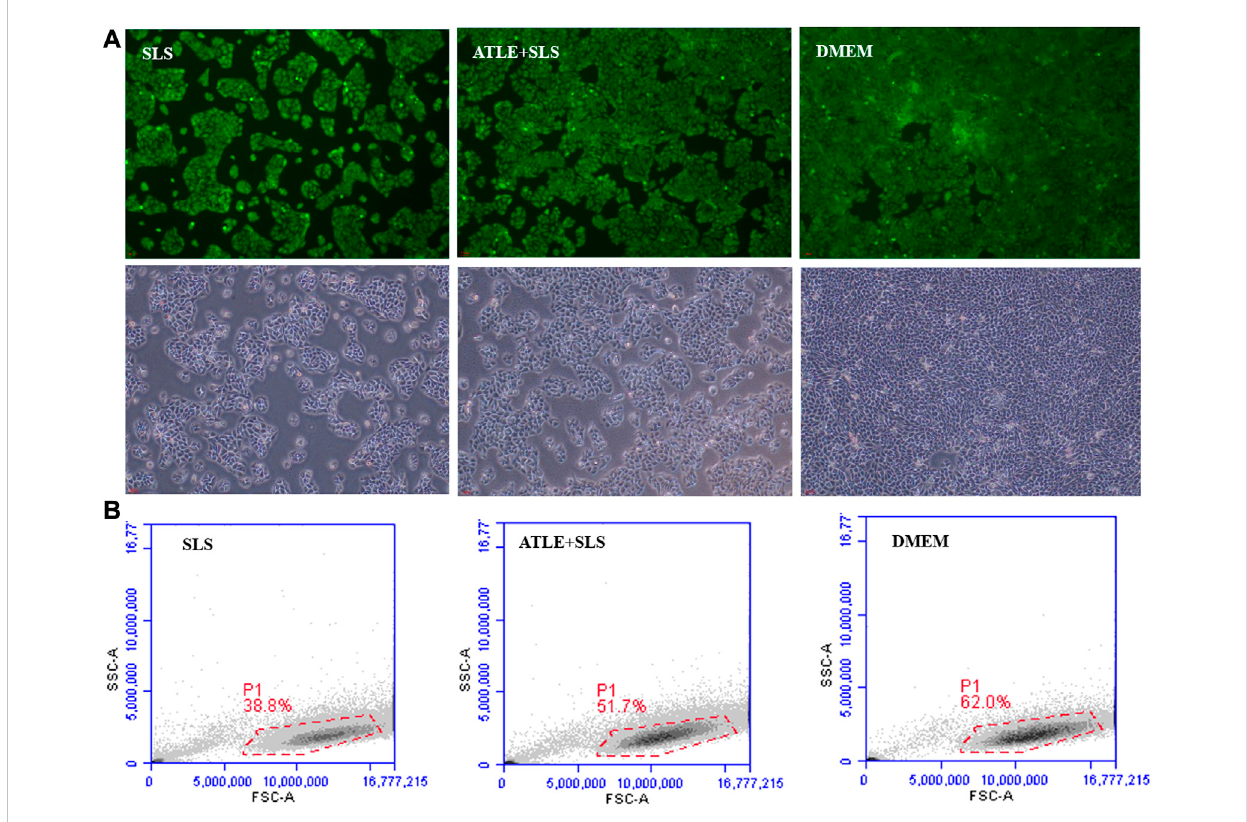
Inhibition of ATLE on ROS and apoptosis. (A) The intracellular ROS was detected with DCF-DA staining. (B) To investigate the effect of ATLE on cell apoptosis, the survival rate of HaCaT cells was analyzed by fl ow cytometry. * p <